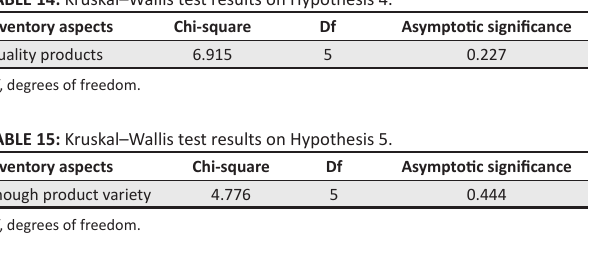
TABLE 16: Literature and empirical findings relating to the different inventory decisions. Inventory decisions